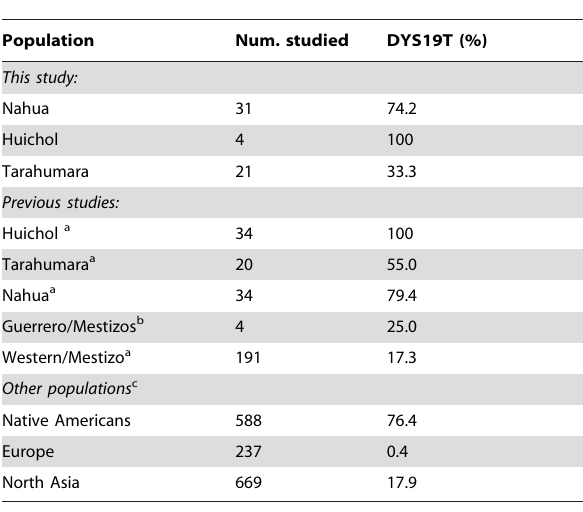
Table 2. Frequency of polymorphisms in DYS19T of the Y- chromosome in Native and Mestizo Mexican Populations and other